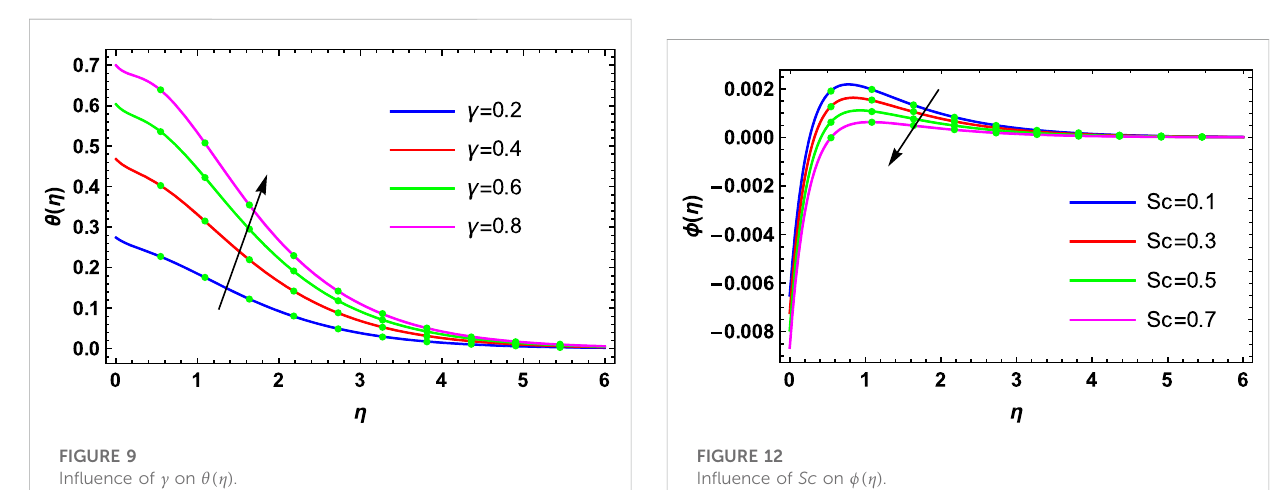
FIGURE 8 In fl uence of Nt on θ ( η ) .